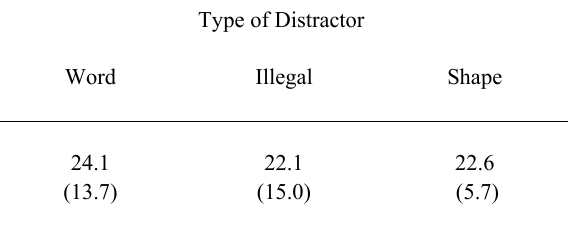
Table 1: Mean RDE magnitudes in ms for Experiment 3 (with standard deviations in parentheses) for each Distractor